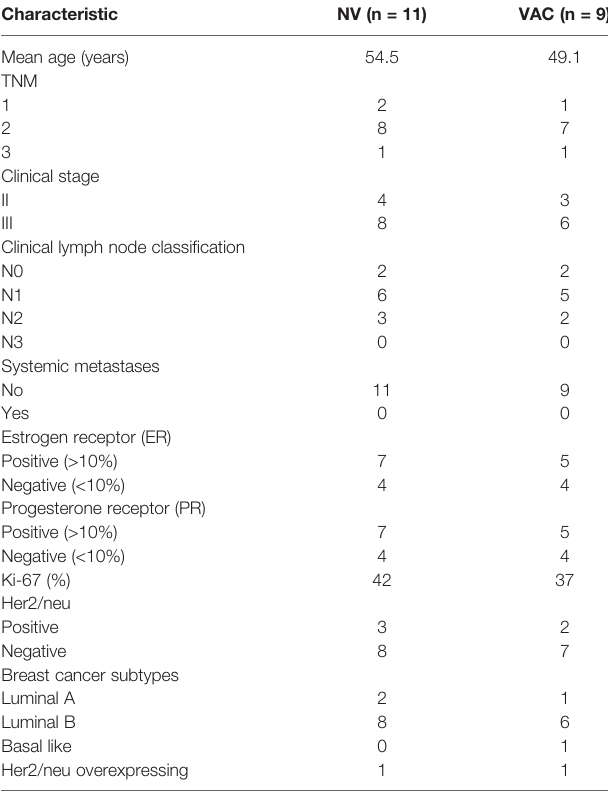
TABLE 1 | Patients ’ clinical